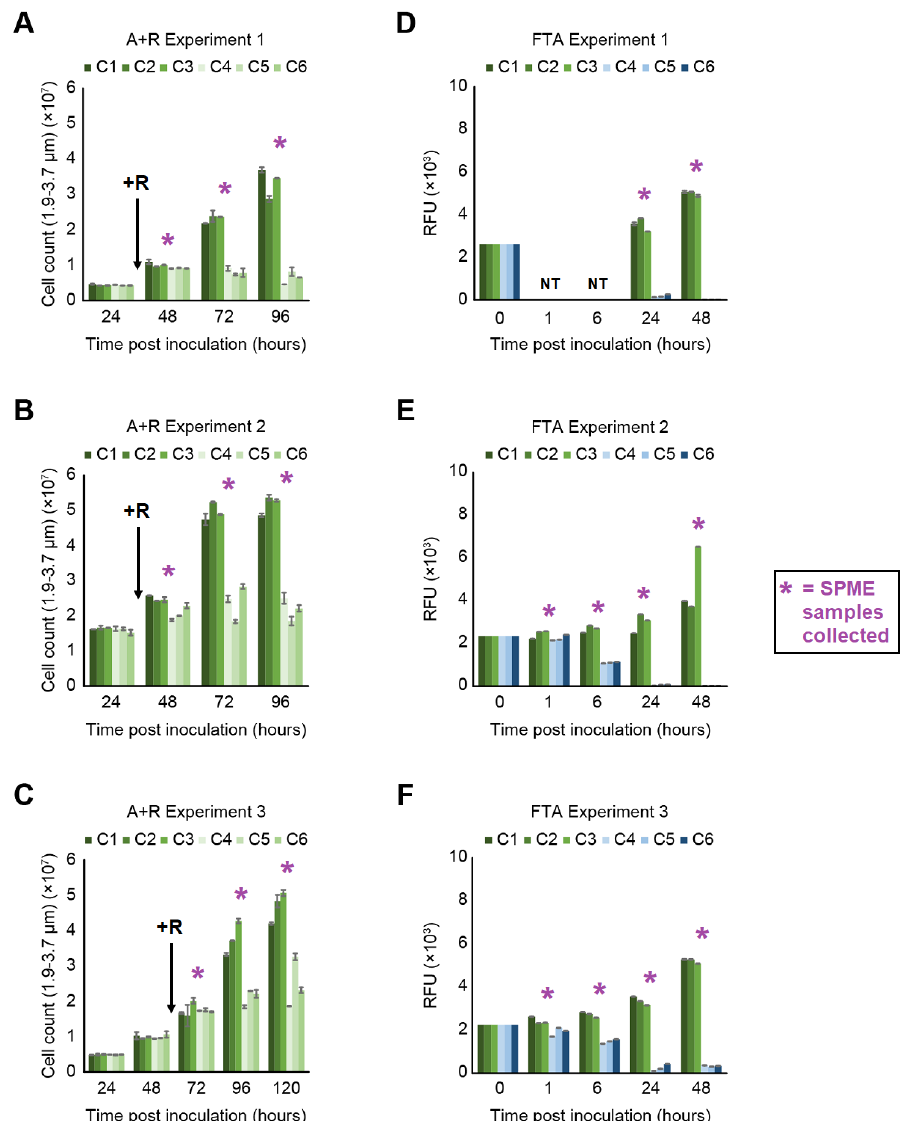
Figure 1. ( A – C ) Algae concentrations as determined by direct enumeration for three healthy algae cultures (C1–C3) and three rotifer grazing algae cultures (C4–C6) for the three A + R experiments. Rotifer addition marked by “+R” with an arrow at the relevant point in time. ( D – F ) Fluorescence measurements for three healthy algae cultures (C1–C3) and three freeze–thawed algae cultures (C4–C6) for the three Freeze–Thaw Algae (FTA) experiments. The error bars represent standard deviation calculated from technical replicates for each sample ( n = 2). The starting concentrations of the FTA experiments were equivalent at the time of algal inoculation (t = 0 h), and thus the standard deviation for these measurements is zero. No timepoints for1 h and 6 h in FTA Experiment 1 were taken, as denoted by “NT”. SPME samples were collected at timepoints in experiments marked by an asterisk